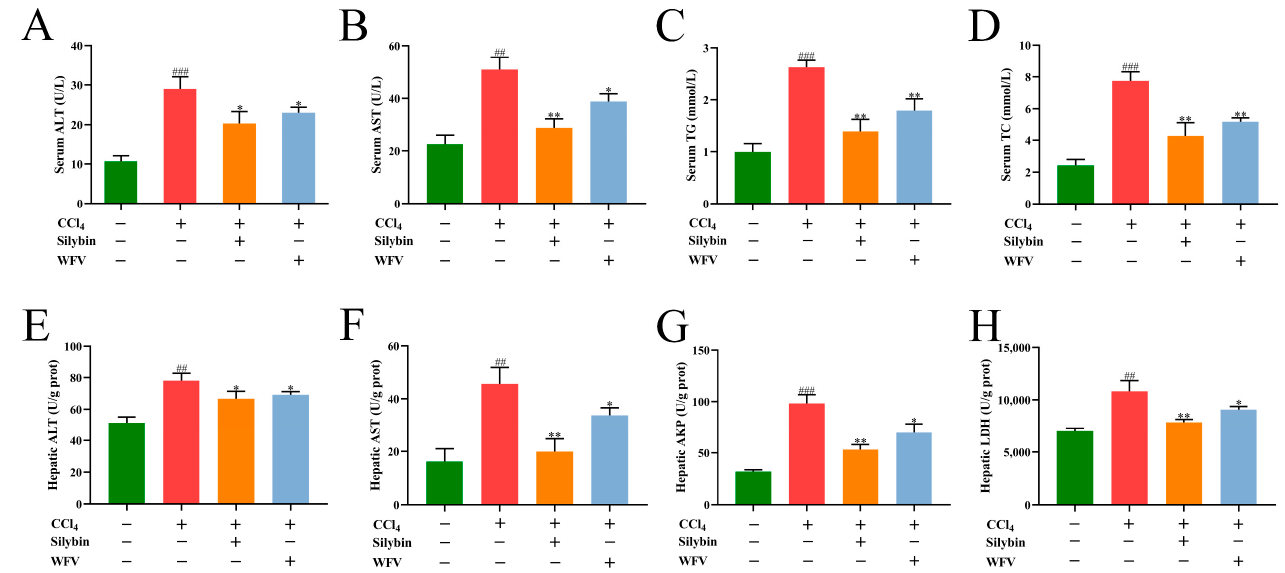
Figure 3. Effect of WFV on biochemical indexes in mice with oxidative liver trauma. The levels